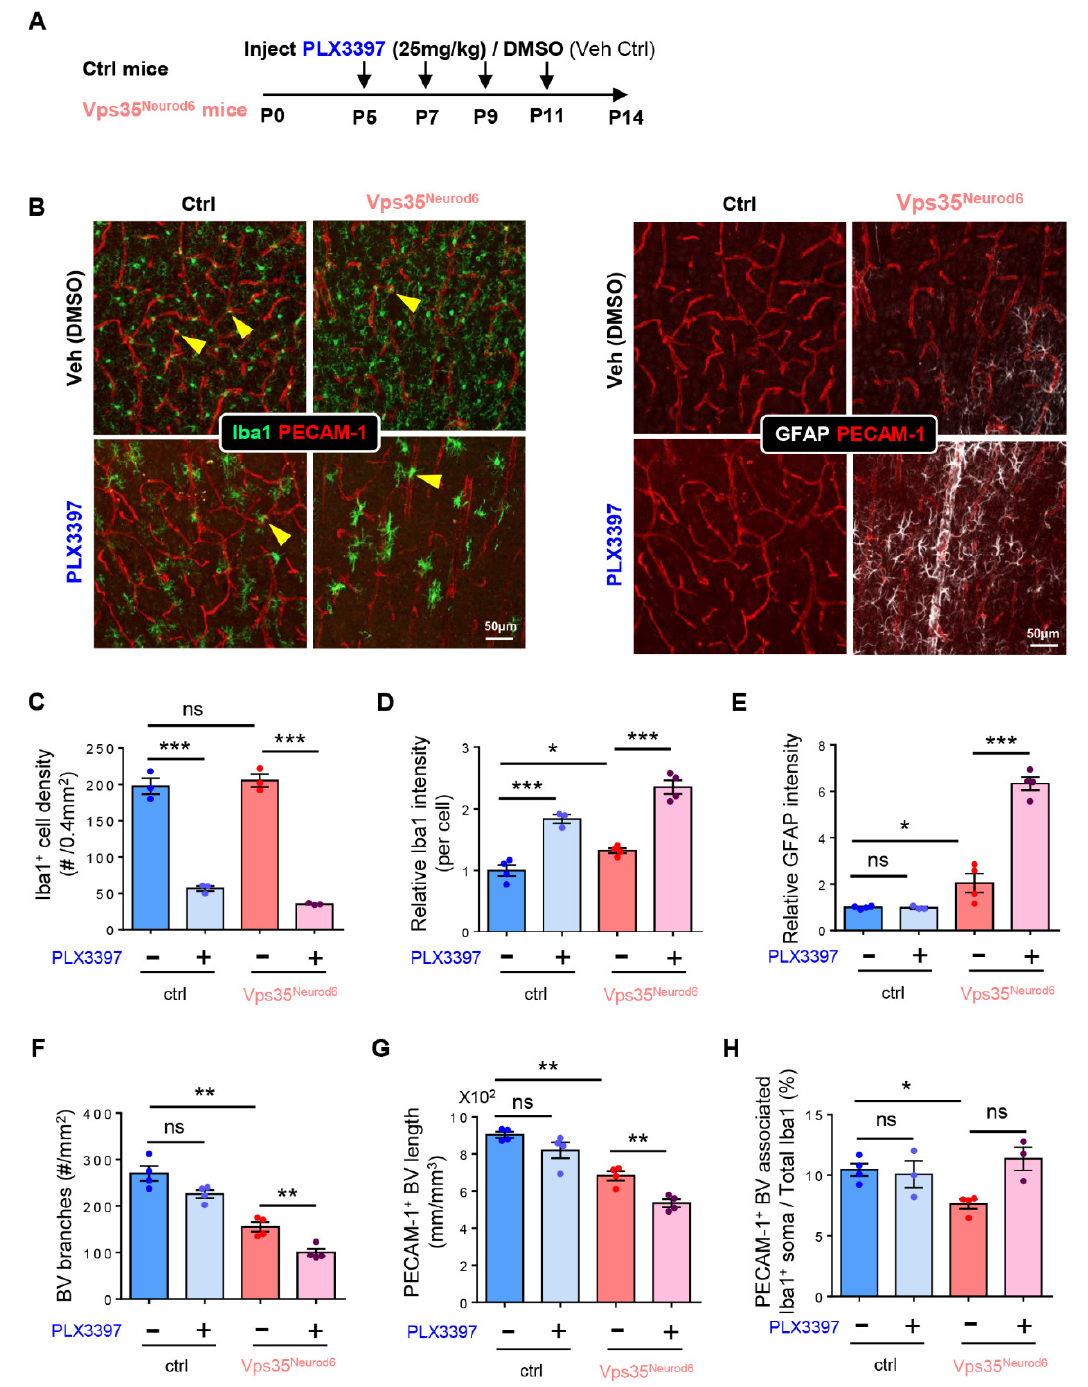
Figure 8. Decrease in PECAM-1 + vessels and increase in GFAP + astrocyte in Vps35 Neurod6 mice depleting microglia. ( A ) Schematic illustration of PLX3397 injection protocol in control and Vps35 Neurod6 mice. ( B ) Representative images of cortical brain sections coimmunostained with PECAM-1 and Iba1 of control and Vps35 Neurod6 mice injected with PLX3397 and DMSO, respectively, at P14. ( C ) Quantification analysis of Iba1 + cell density in control and Vps35 Neurod6 mice (n = 3~4 mice per group; two-tailed unpaired t test). ( D ) Quantification analysis of Iba1 + cell intensity in control and Vps35 Neurod6 mice (n = 3~4 mice per group; two-tailed unpaired t test). ( E ) Quantification analysis of GFAP intensity in control and Vps35 Neurod6 mice (n = 3~4 mice per group; two-tailed unpaired t test). ( F ) Quantification analysis of BV branches in control and Vps35 Neurod6 mice (n = 3~4 mice per group; two- tailed unpaired t test). ( G ) Quantification analysis of PECAM-1 + BV length in control and Vps35 Neurod6 mice (n = 3~4 mice per group; two-tailed unpaired t test). ( H ) Quantification analysis of PECAM-1 +